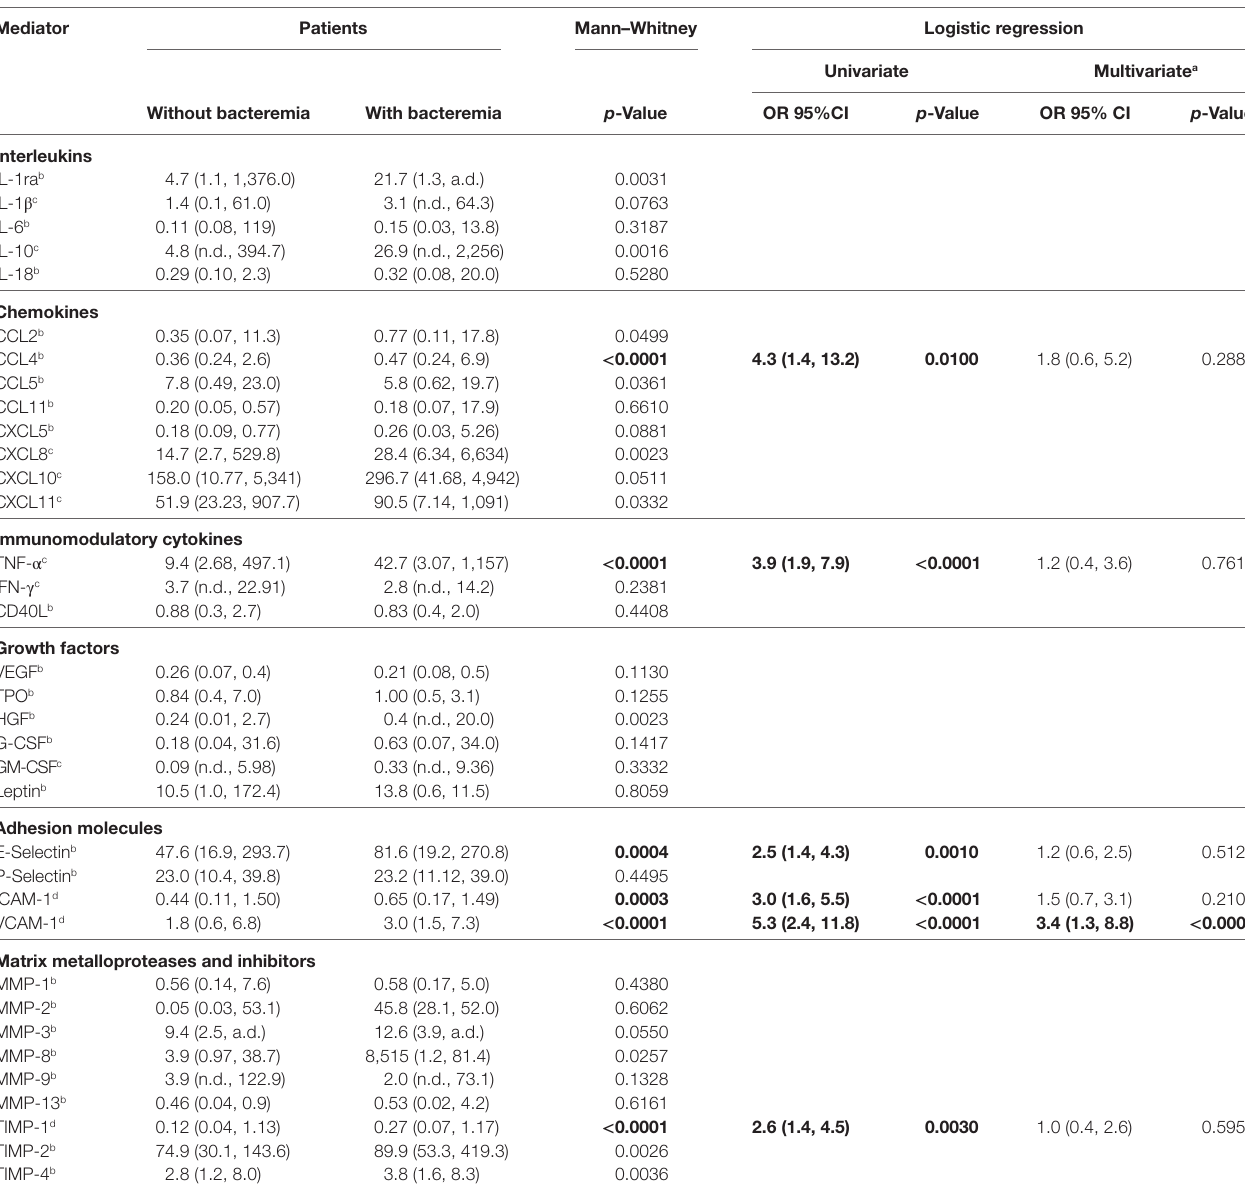
TaBle 2 | Mediators in patients with and without bacteremia; the median value and range are given.